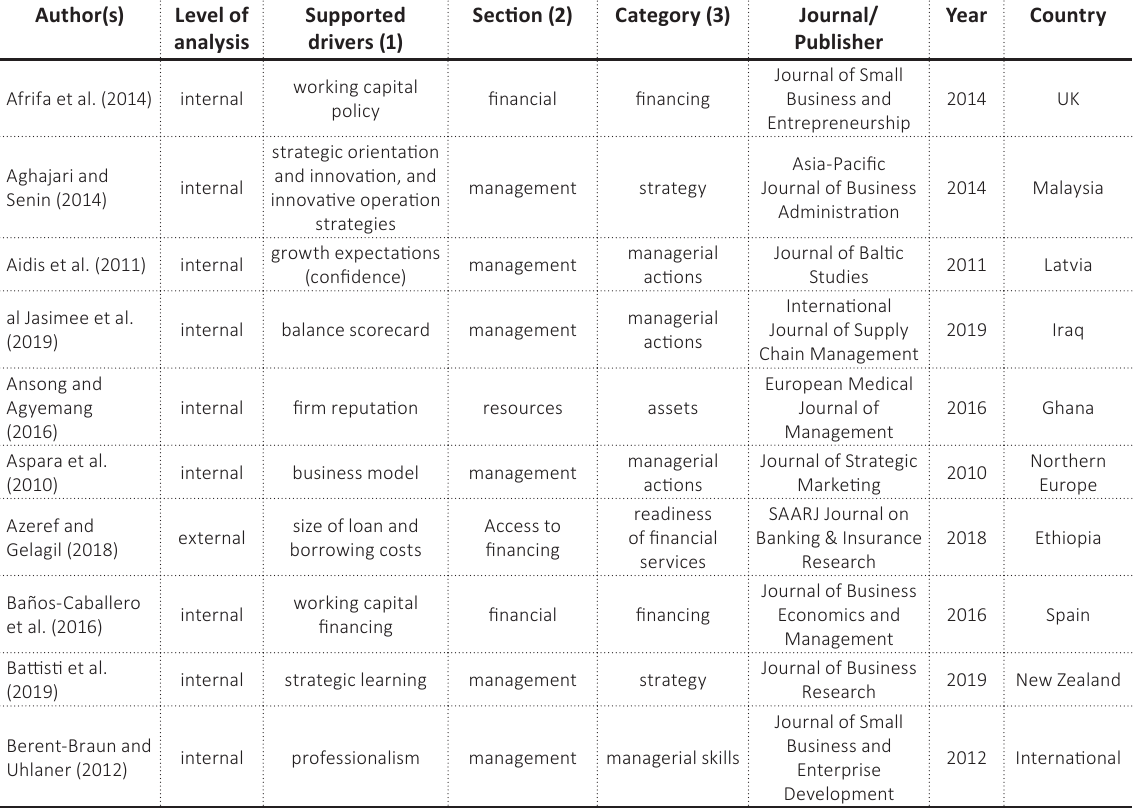
Table A1. Full list of contingency